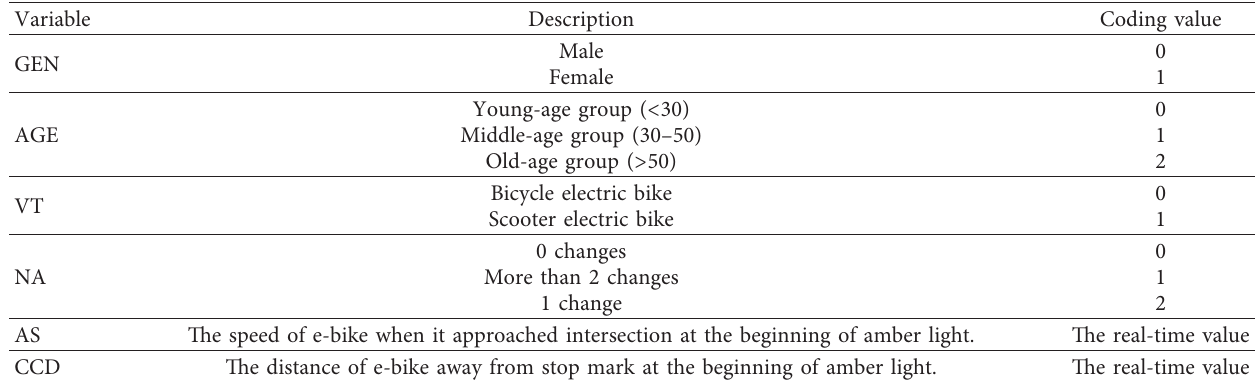
Table 1: Definition of variables coded.